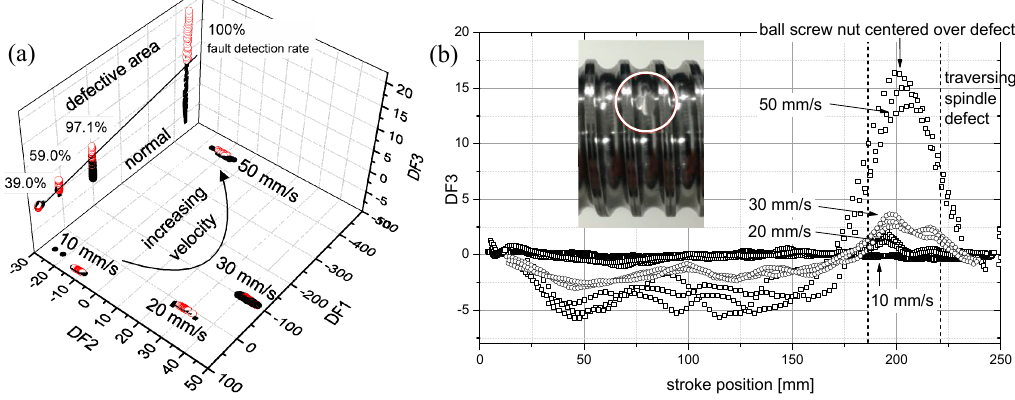
Figure 4. ( a ) LDA projection of 30 selected vibration features, n = 2883; classification rate determined with 10-fold CV for Mahalanobis distance classifier; ( b ) deliberate abrasion as local defect of the spindle and corresponding signal of DF3 vs. stroke position (moving average over 10 data